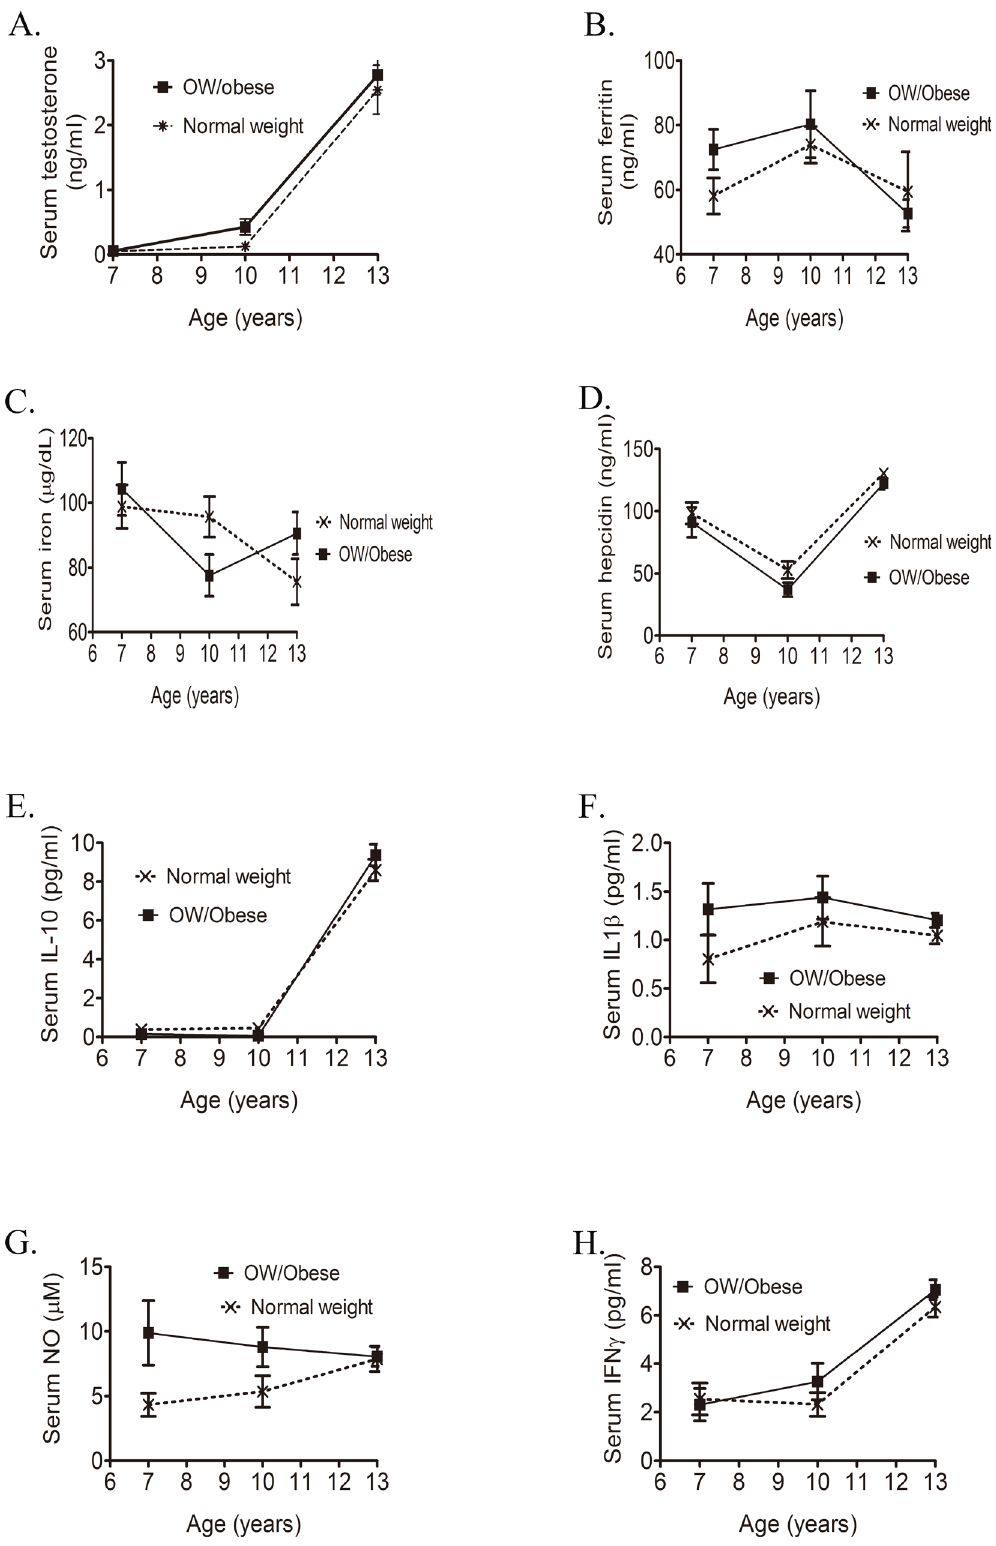
Fig 1. Distributions of serum testosterone (A), ferritin (B), iron (C) hepcidin (D), interleukin (IL)-10 (E), IL-1 β (F), nitric oxide (NO) (G), and interferon (IFN)- γ (H) stratified by age and the body-mass index (BMI) ( n = 137).